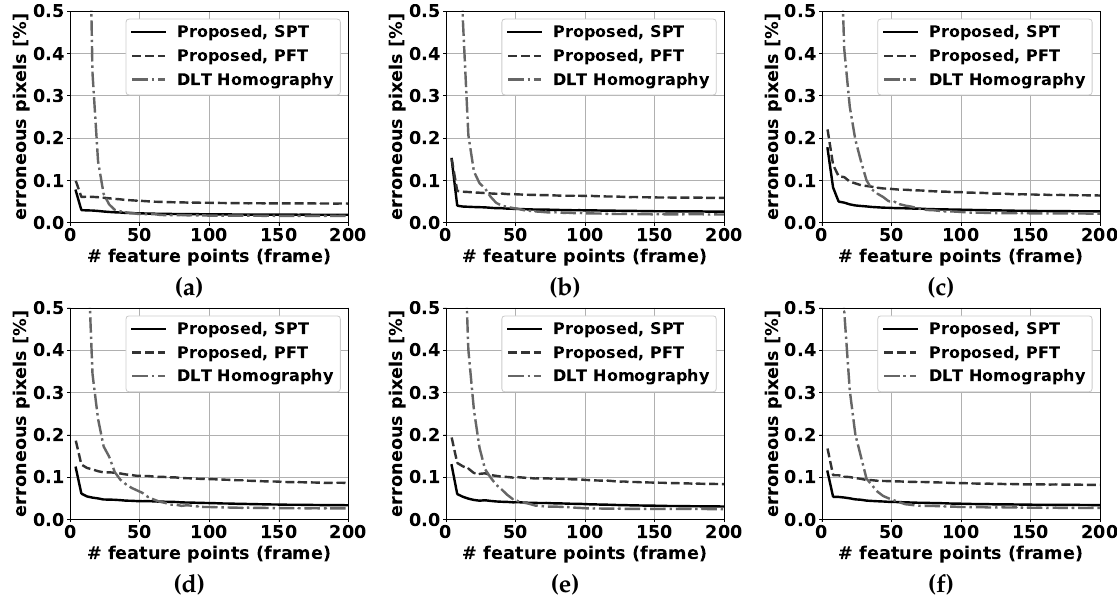
Figure 6. Percentage of erroneous pixels in fixed tilt sequences where feature points are selected by using the algorithm described in [38]. The proposed panning for fixed tilt (PFT) method and the simultaneous pan and tilt (SPT) method are compared to the DLT homography method [24] for 6 sequences: ( a ) 0 ◦ tilt, ( b ) 5 ◦ tilt, ( c ) 10 ◦ tilt, ( d ) 15 ◦ tilt, ( e ) 20 ◦ tilt, ( f ) 25 ◦ tilt. Please note that the number of erroneous pixels is significantly above 0.5% of the total number of pixels for a low number of feature correspondences, and cannot be clearly depicted on these